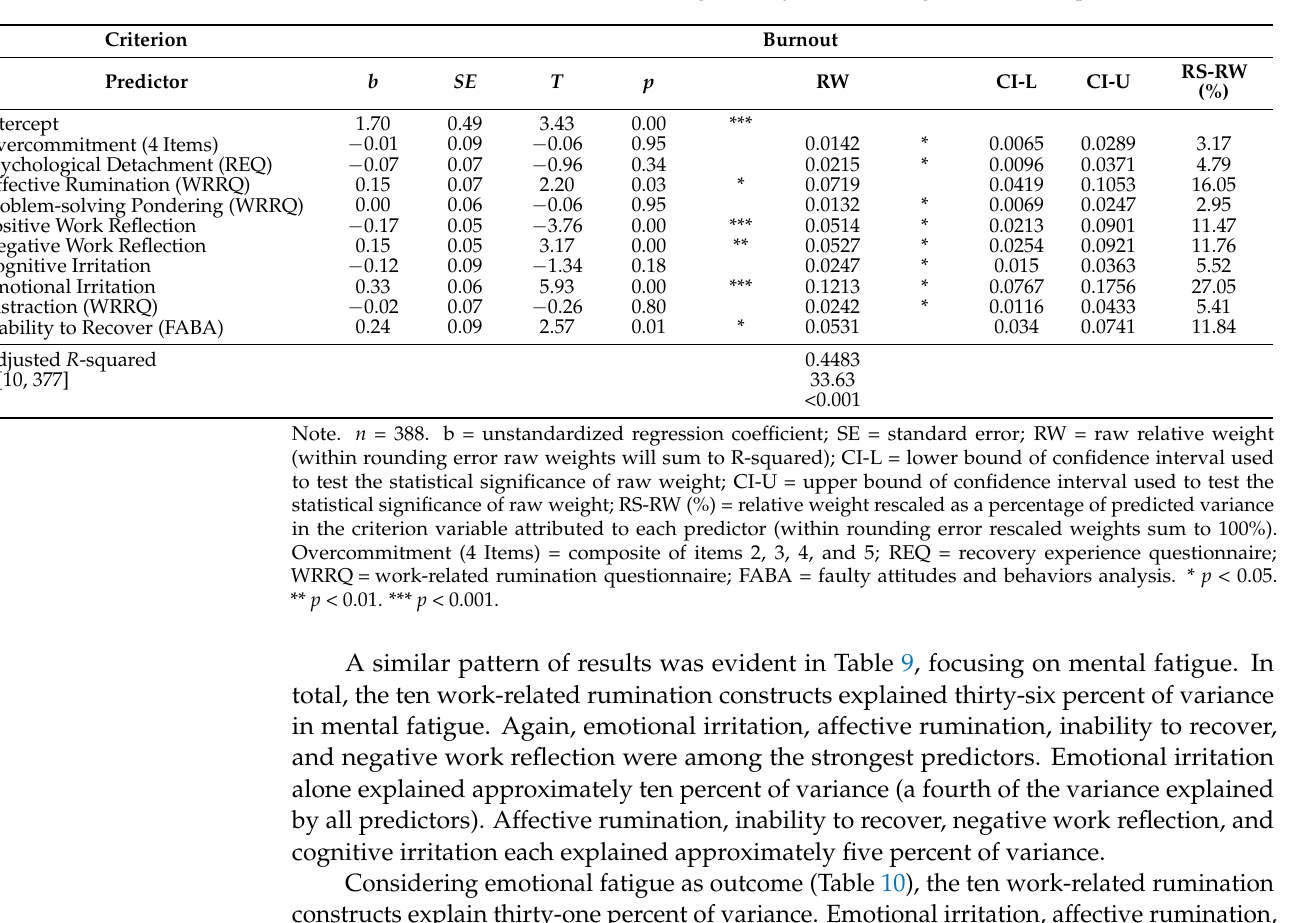
Table 11. Coefficients of the Relative Weight Analyses Predicting Burnout (Sample